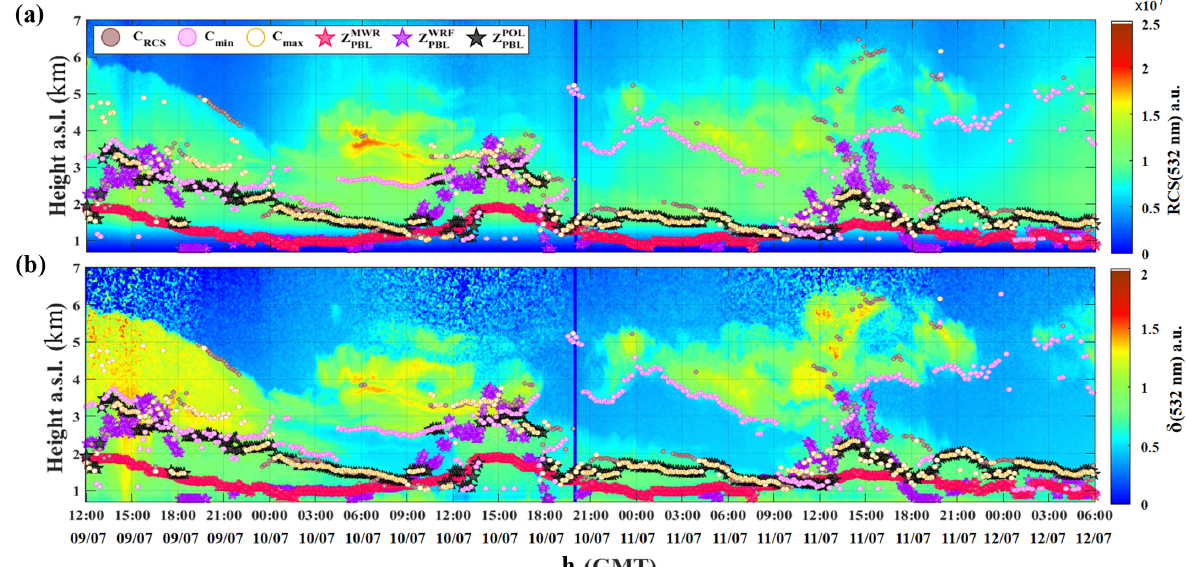
Figure 7. Temporal evolution of the range-corrected signal (RCS) (a) and the perpendicular-to-parallel signal ratio ( δ) (b) in the period 12:00UTC 9 July–06:00UTC 12 July 2012 (colour maps). The scatter plots represent the candidate for z PBL : C RCS (brown dot), C min (pink dot) and C max (ochre dot). The z PBL determined with POLARIS (black star), using MWR measurements (violet star) and derived from the WRF model (red star), is shown. The measure gap is a dark-current